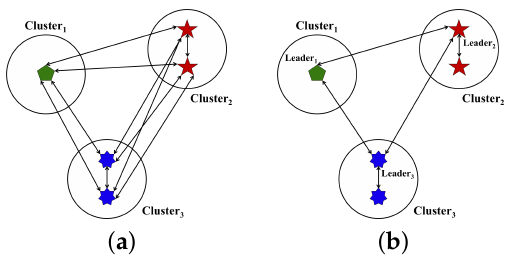
Figure 4. Two heterogeneous MAS, including N = 5 agents in P = 3 different clusters. ( a ) Com- munication topology of a complete graph G without any leader. ( b ) Communication topology of a connected graph G with a leader at each